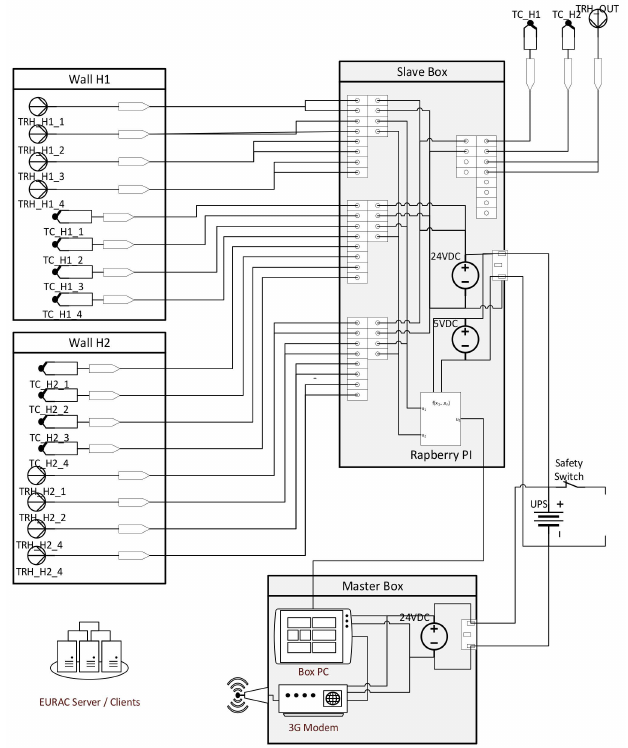
Figure 9. Graphical scheme of the monitoring system (design by D.